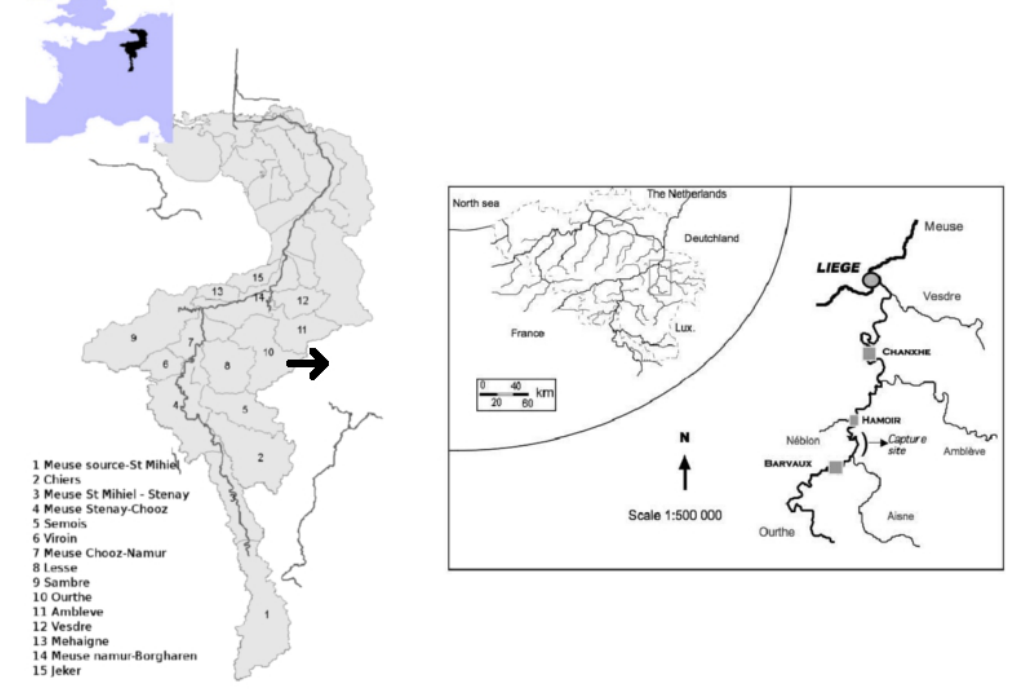
Fig. 1. The Meuse river basin and the sub-basins upstream of Borgharen. Sub-basin 10 (Ourthe) is used in the case